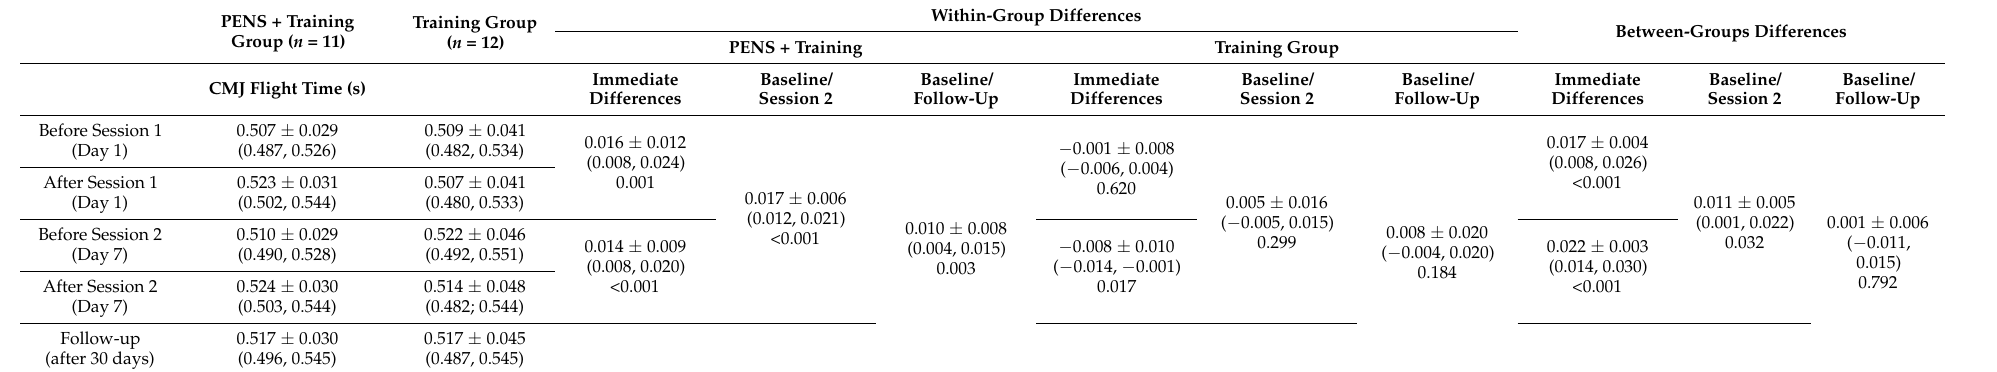
Table 2. Timeline scores, within-group, and between-group changes of flight time (s) during the Countermovement Jump (CMJ).